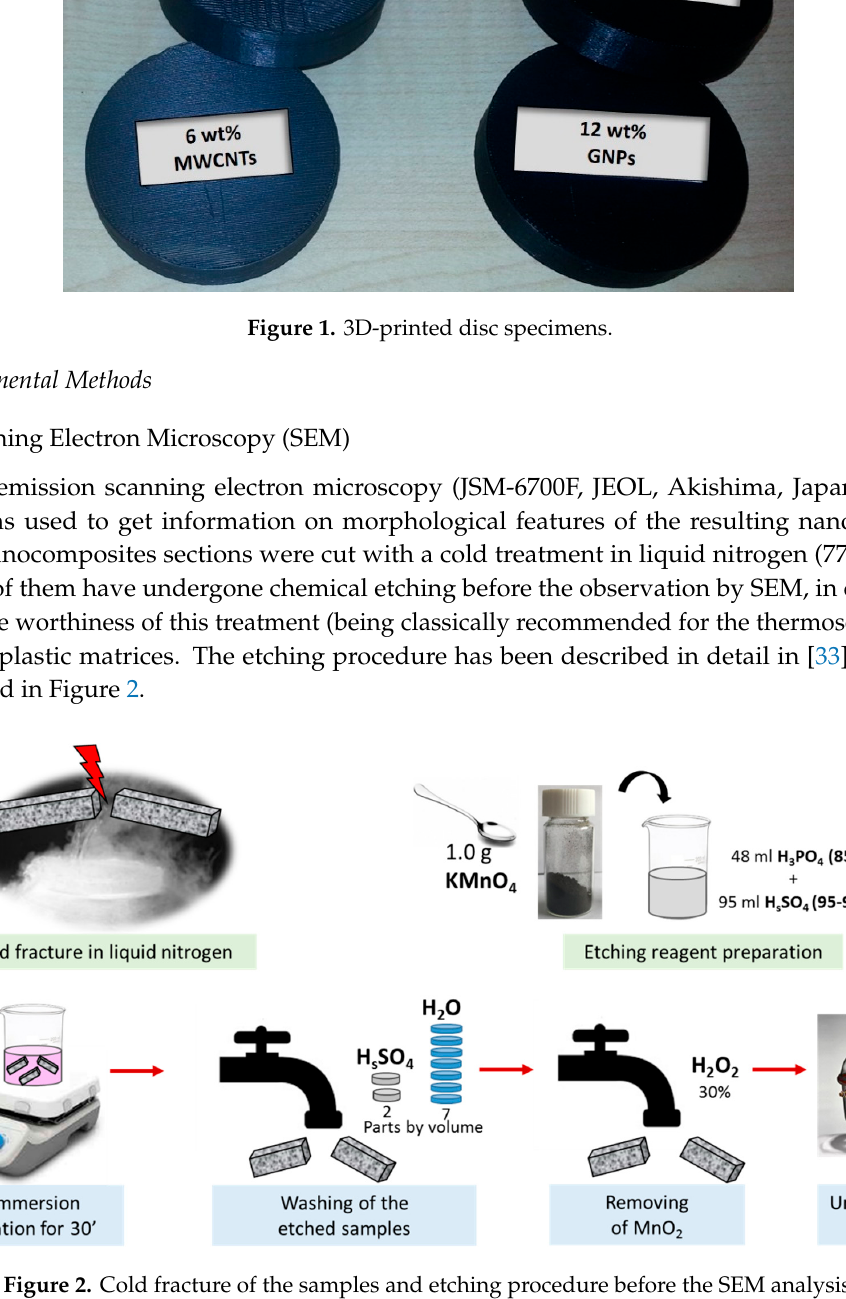
Figure 2. Cold fracture of the samples and etching procedure before the SEM analysis.